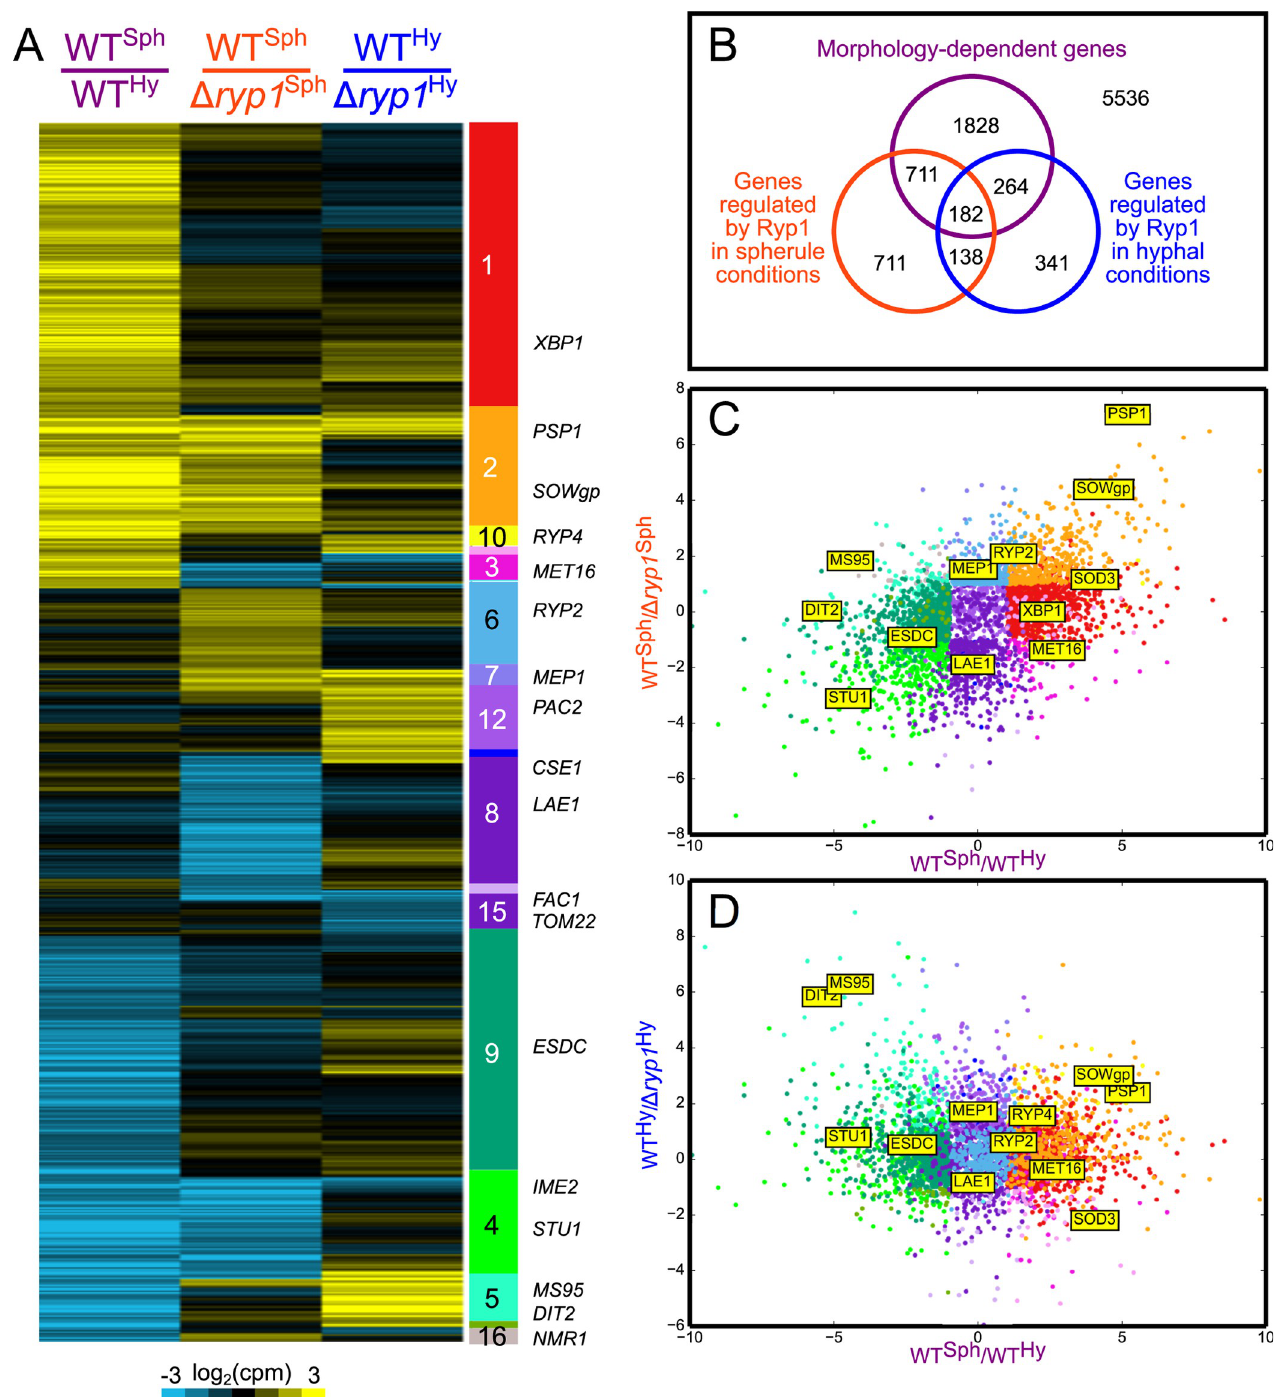
Fig 3. Ryp1 regulates distinct sets of genes in spherules and hyphae. (A) Heatmap showing differential expression of the 4175 genes described in the text. Genes are grouped by expression pattern (significantly up, down, or neutral in each of the three contrasts) with different classes labeled in the color bar to the right of the heatmap. The position of genes of interest in the heatmap are indicated to the right of the color bar. (B) Venn diagram of genes observed to be morphology-regulated (differentially expressed in WT Sph /WT Hy ), Ryp1-dependent in spherulation conditions (differentially expressed in WT Sph / Δ ryp1 Sph ), or Ryp1-dependent in hyphal conditions (differentially expressed in WT Hy / Δ ryp1 Hy ). (C and D) Scatter plots of the differentially expressed genes comparing the WT spherule-enrichment (right) or hyphal-enrichment (left) to ryp1 -depletion (top) or ryp1 -enrichment (bottom) in (C) spherules or (D) hyphae. Genes in the scatter plots are colored by expression pattern, as in the color bar of (A).